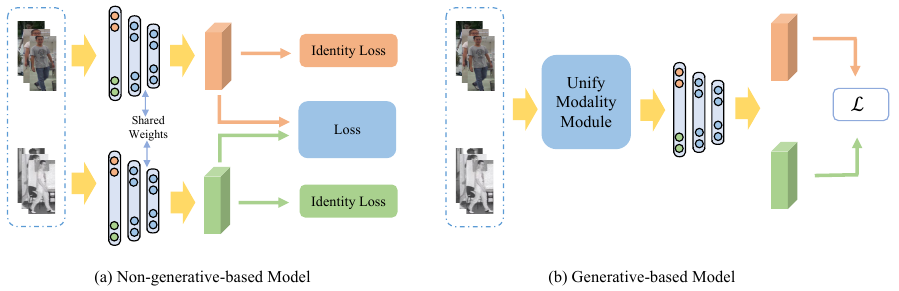
Figure 2. Illustration of two different pipelines of